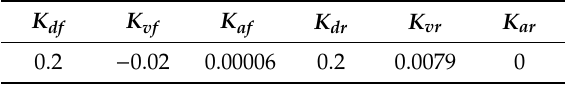
Figure 6. Specimen and experimental setup. Table 1. Parameter values of three-variable control method with velocity positive feedback (TVCM-VPF) in shaking table substructure testing